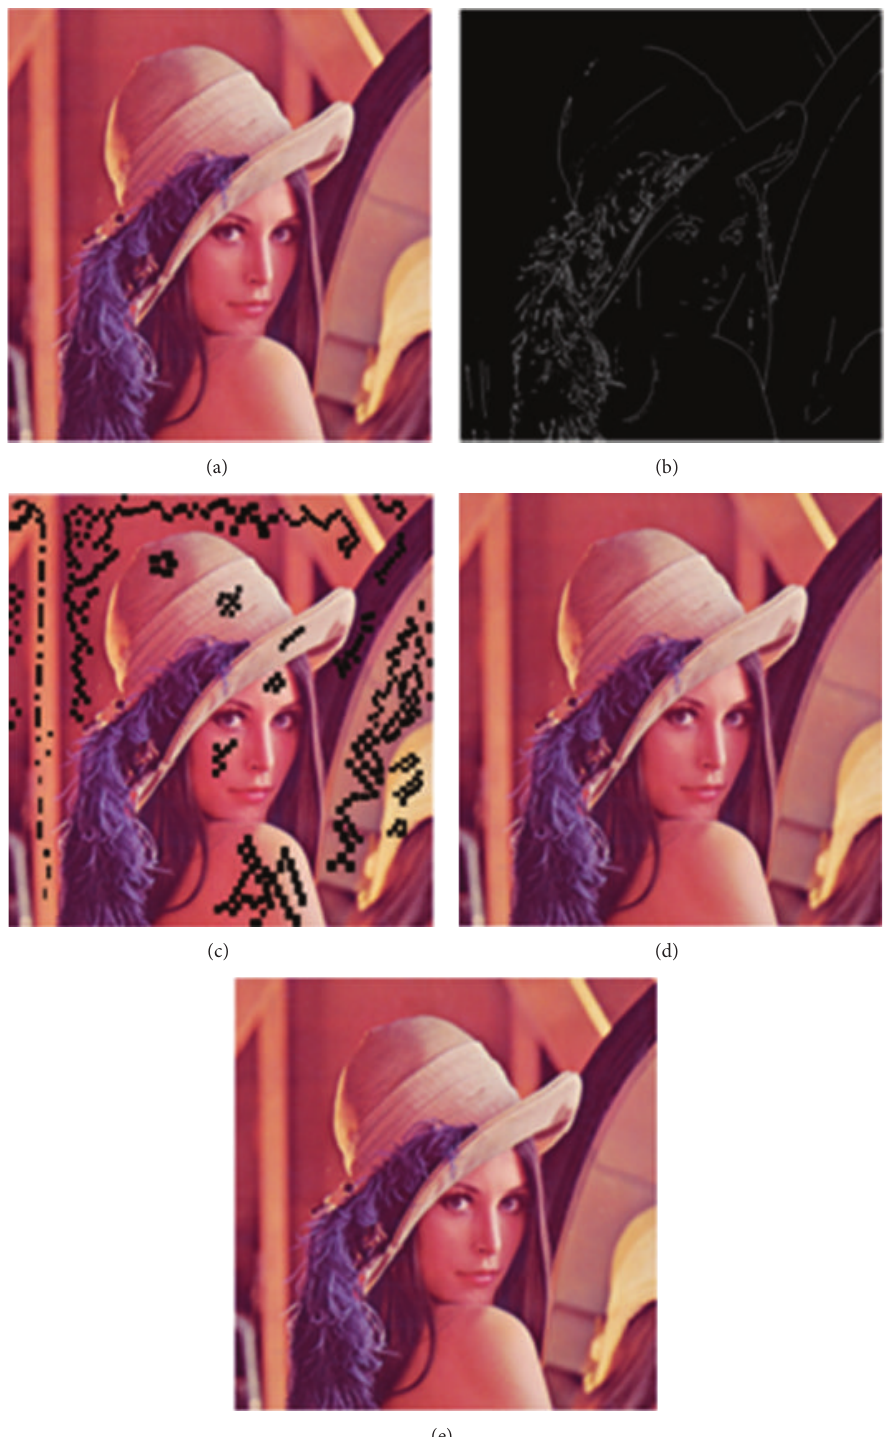
Figure 6: Comparison with JPEG 2000 with QP = 75. (a) Input image. (b) Edges. (c) Image with 25% of portions removed. (d) Reconstructed image after inpainting and texture synthesis. (e) Reconstructed image by JPEG